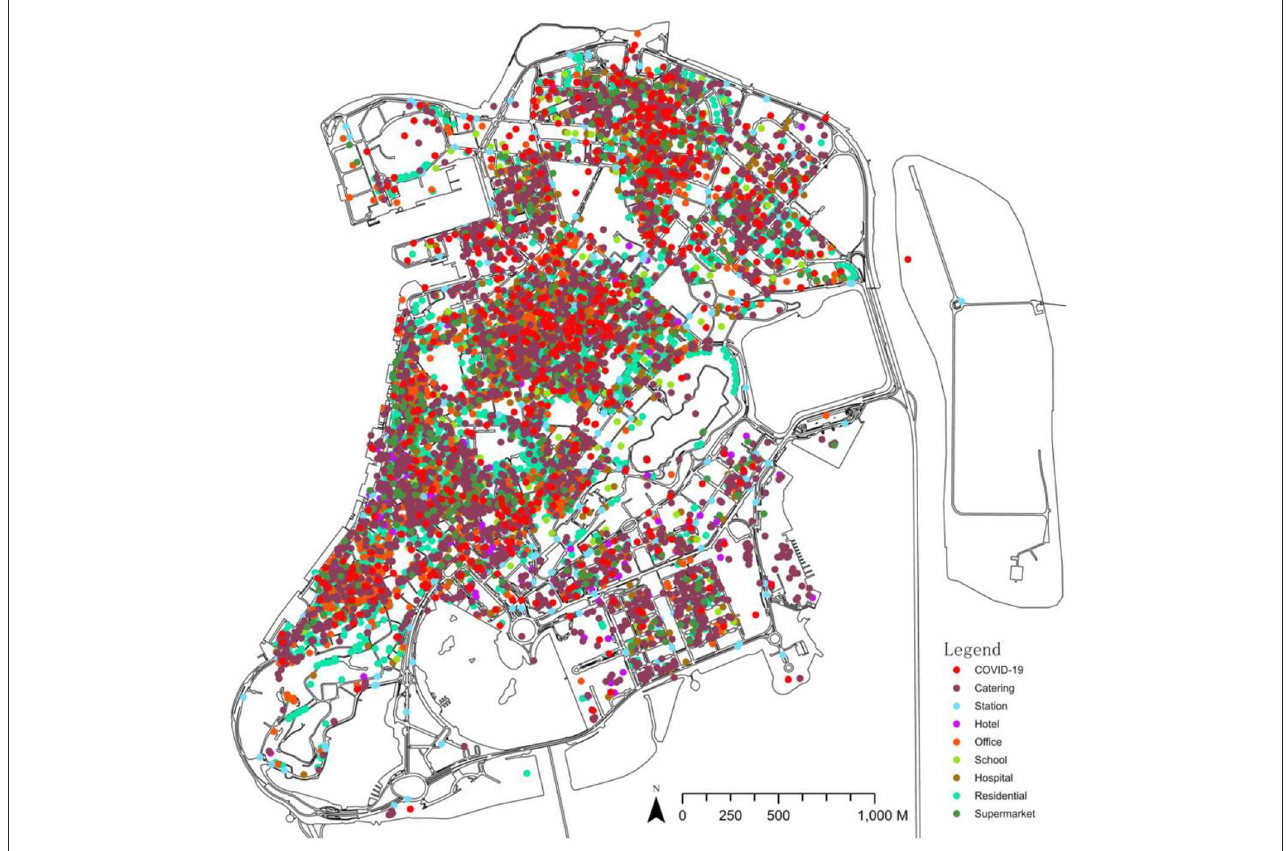
FIGURE1 The footprint and POI distribution of the COVID-19 epidemic on the Macau Peninsula.